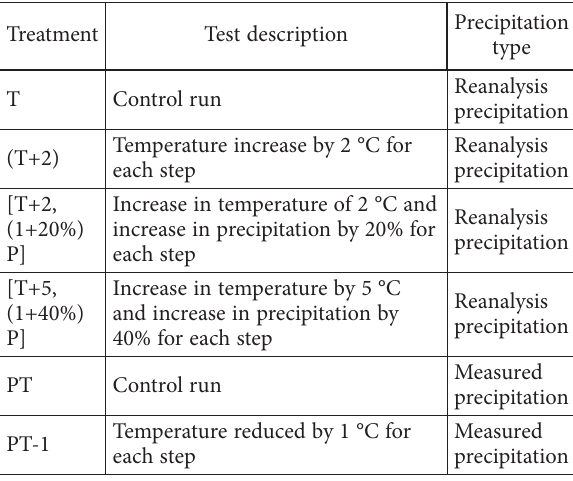
Table 1. Summary of the experimental